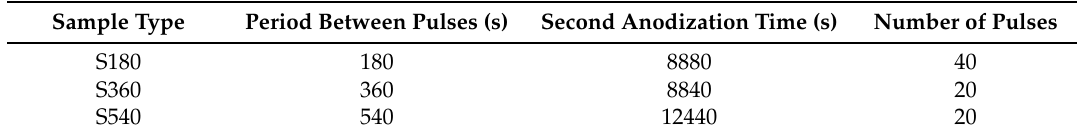
Table 1. Name and second anodization description of